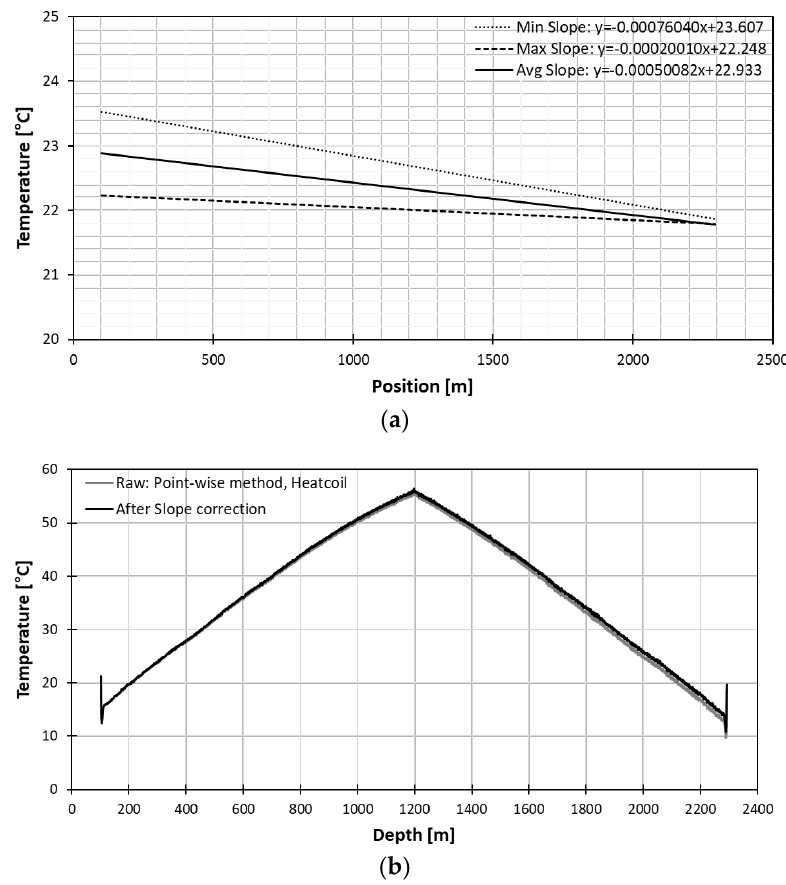
Figure 10. ( a ) Slope curve of pointwise method with heat coil and ( b ) heat profile after pointwise heat coil slope correction.